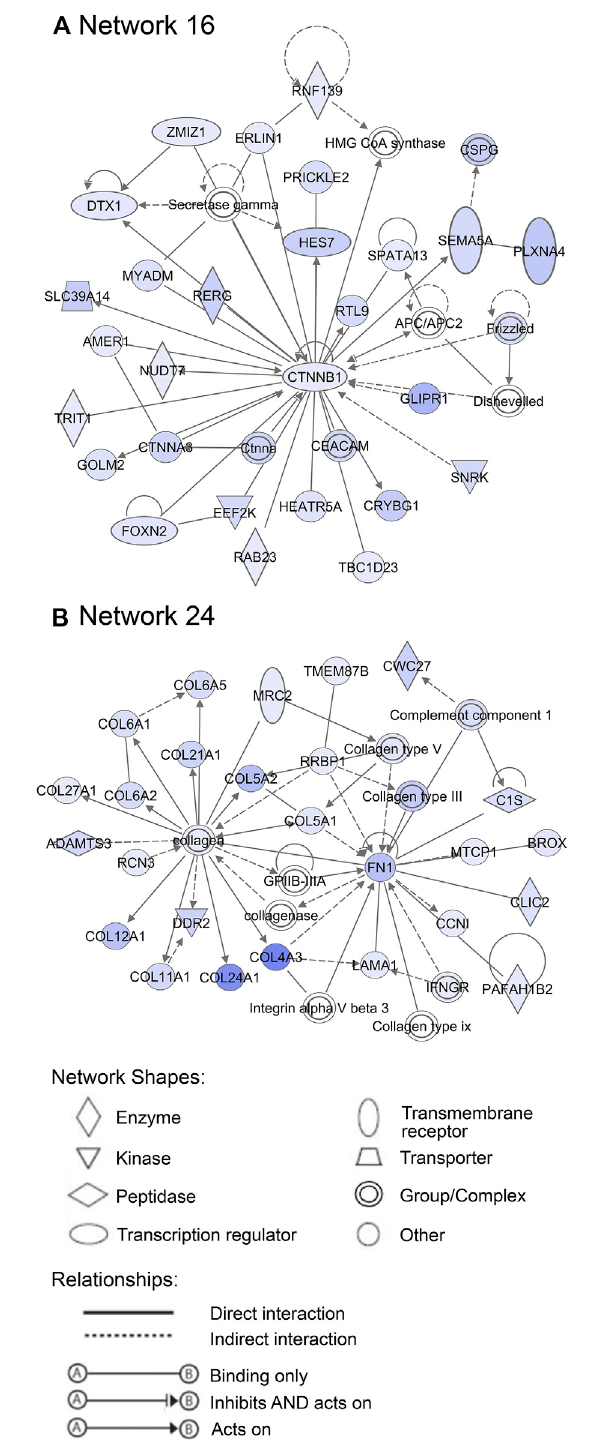
FIGURE 8 | Important networks associated with cluster 2. (A) Network 16 contains β -catenin as central player, whereas (B) network 24 is associated withthecomponentsofextracellularmatrix,suchascollagensand fi bronectin. Blue color of molecules represents upregulation in the second half of gestation and the intensity of each color shows the strength of